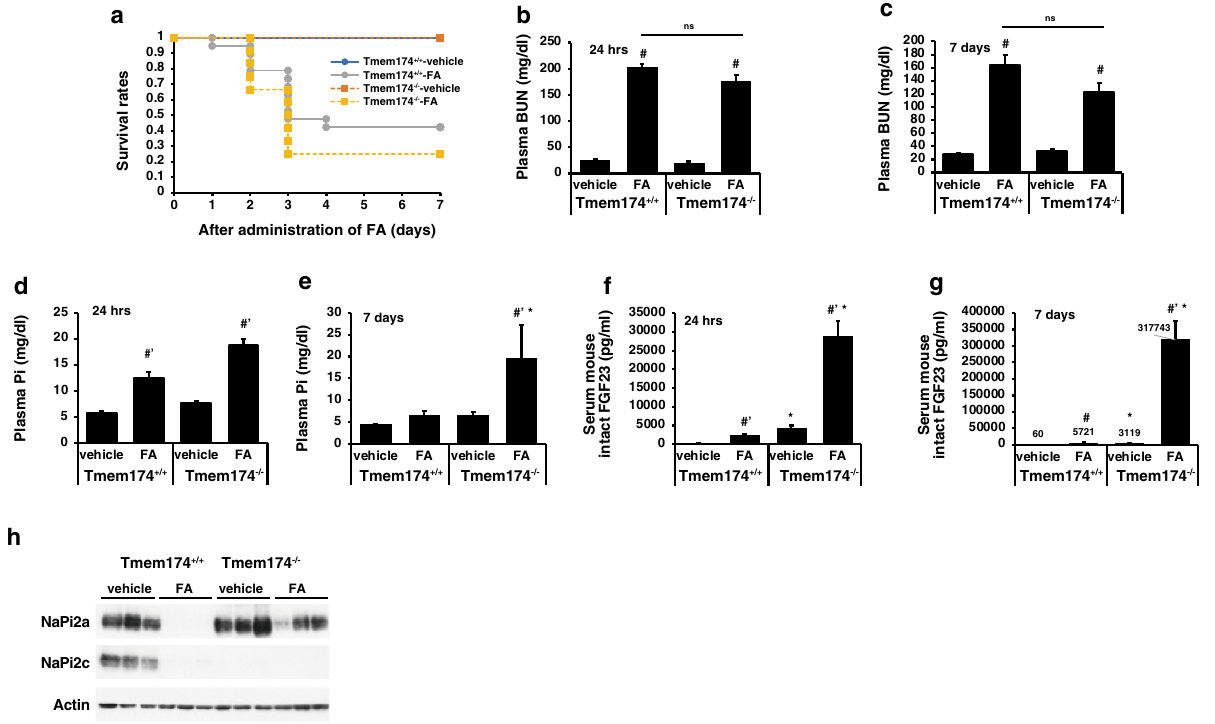
Figure 10. Renal injury in Tmem174 −/− mice. Male Tmem174 +/+ and Tmem174 −/− mice (n = 10–30) were administered folic acid (FA; 240 μg/kg BW). ( a ) Survival curve, Plasma BUN at 24 h ( b ) and 7 days ( c ), plasma Pi at 24 h ( d ) and 7 days ( e ), and serum intact FGF23 at 24 h ( f ) and 7 days ( g ) after administration of FA. Values are mean ± SE. # p < 0.05, #’ < 0.01 vs vehicle of the same genotype, * p < 0.05 vs same treatment of Tmem174 +/+ mice. ns not significant. ( h ) Western blotting analysis of NaPi2a. Each lane was loaded with 20 μg of renal BBMVs of mice 24 h after administration of FA. Actin was used as an internal